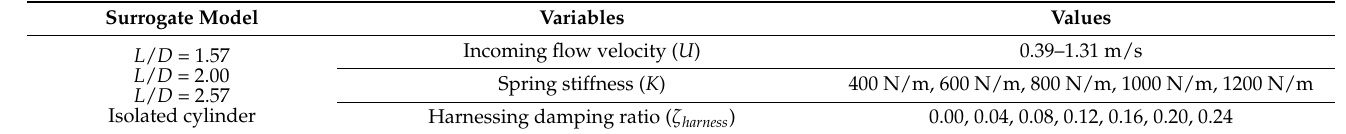
Table 1. Values of experimental design variables ( U , ζ harness , K ) for four different surrogate models. Surrogate Model Variables Values L / D = 1.57 L / D = 2.00 L / D = 2.57 Isolated